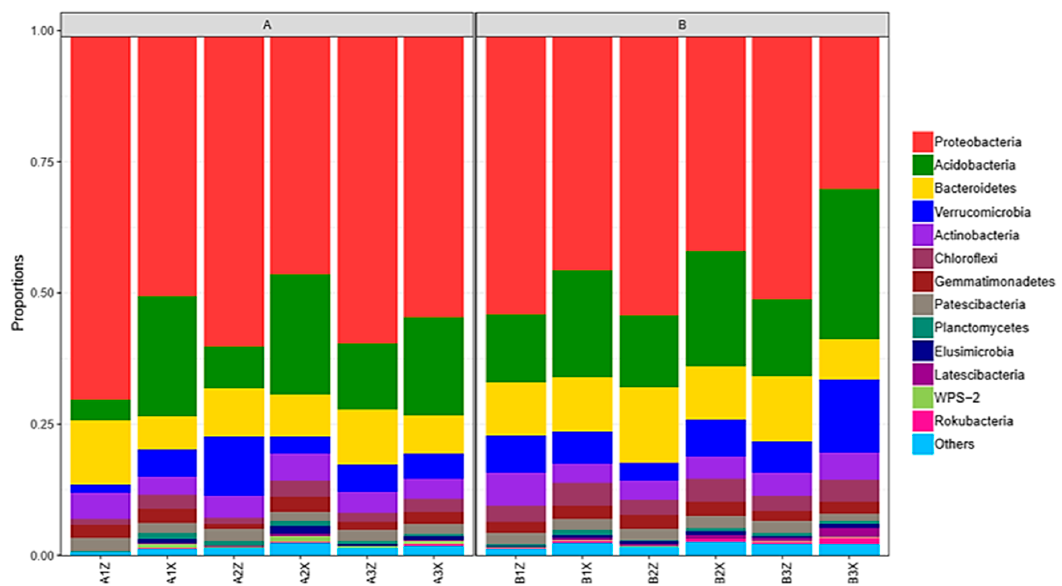
Figure 2. Bacterial species structure of plantation forest litter ( A ) and original forest litter ( B ) at the phylum classification level.